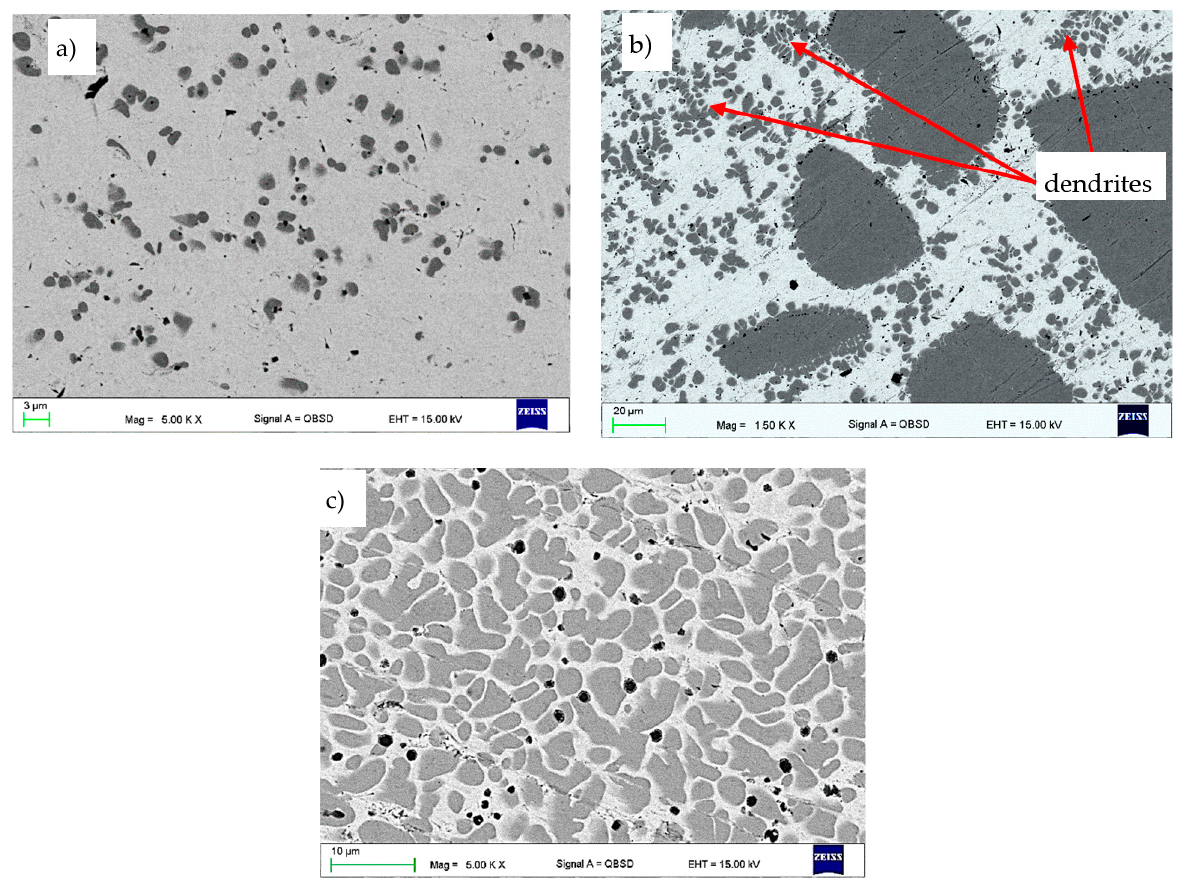
Figure 9. Cr particle morphology in the Cu matrix, cross section of the top layer of the Cu-ETP guide after fusion of CrAl powder: powder feed rate ( a ) 0.2 mm 3 /min; ( b ) 0.4 mm 3 /min; ( c ) 0.8 mm 3 /min; SEM.